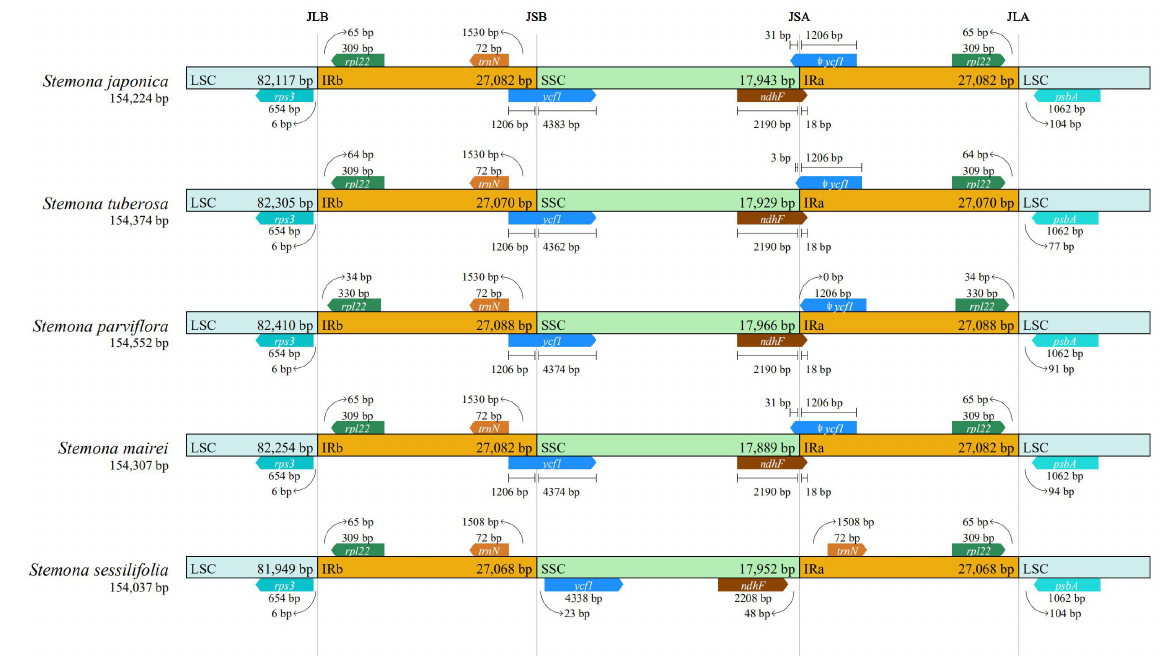
Figure 4. Comparisons of LSC, SSC, and IRs junctions among Stemona species.